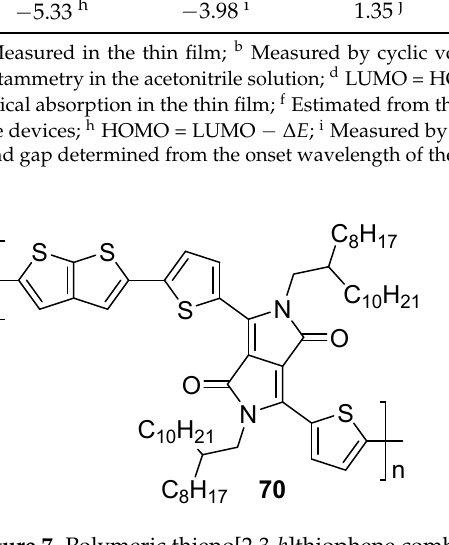
Figure 7. Polymeric thieno[2,3- b ]thiophene combined with diketopyrrolopyrrole. Thieno[3,2- b ]thiophene TT 1 has been used as a π -linker in the push–pull chromo- phores interconnecting the tetracyanoquinodimethane (TCNQ) acceptor and the diphe-